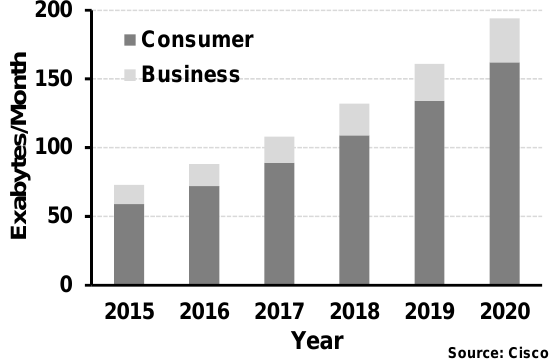
Figure 1. Forecast of total global IP traffic [1].